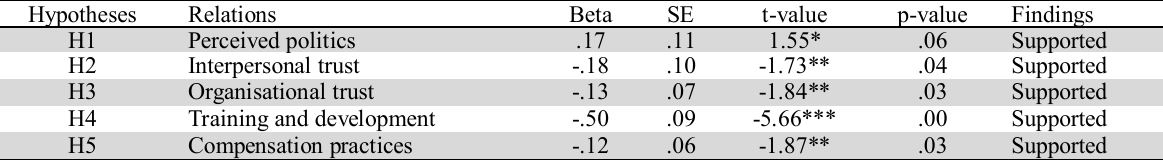
Results of a Multiple Regression Analysis (Turnover Intentions as Dependent